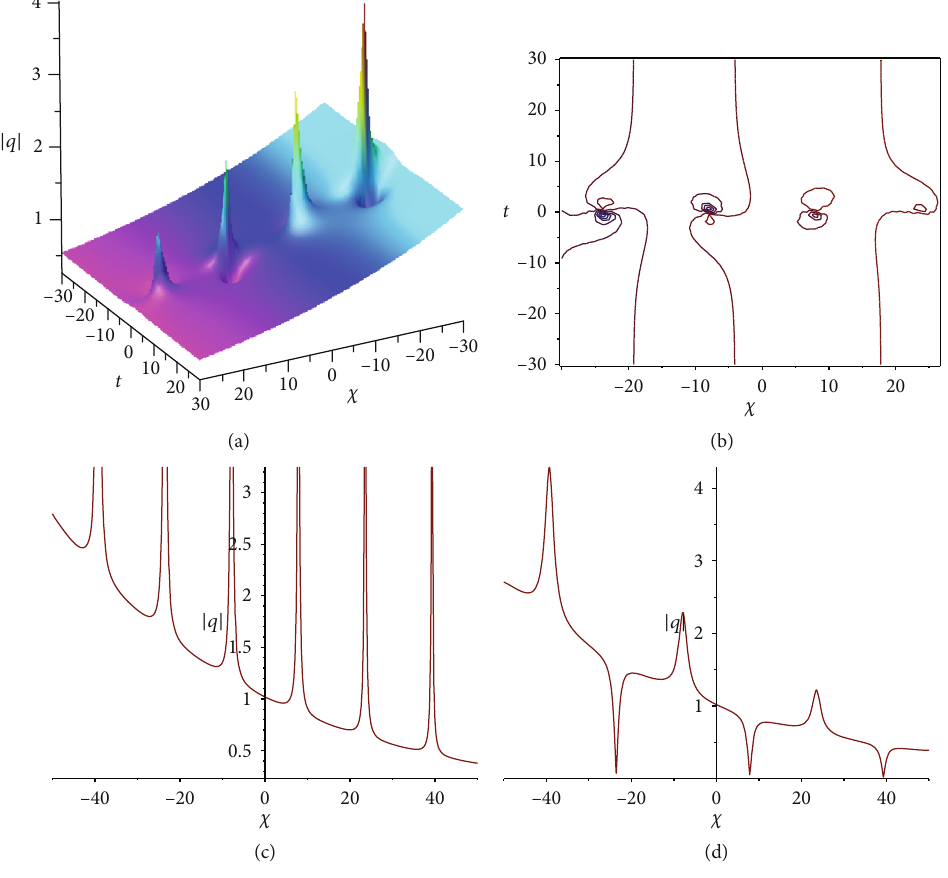
j , (b) contour plot corresponding to (a) and (c, d) the waveform at t = 0 breather